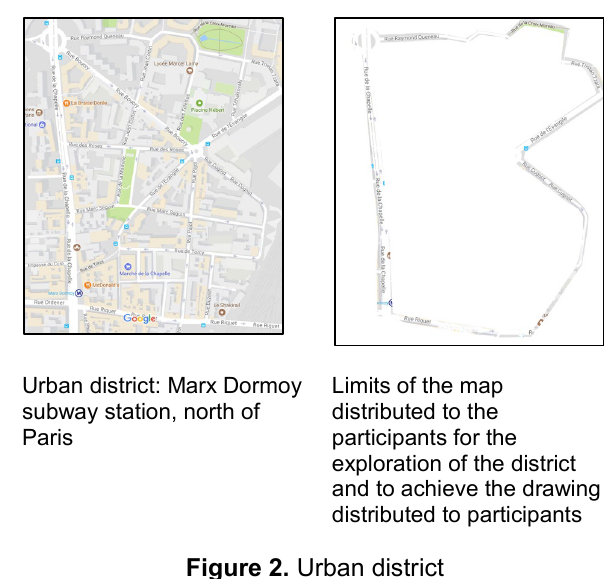
Figure 2. Urban district